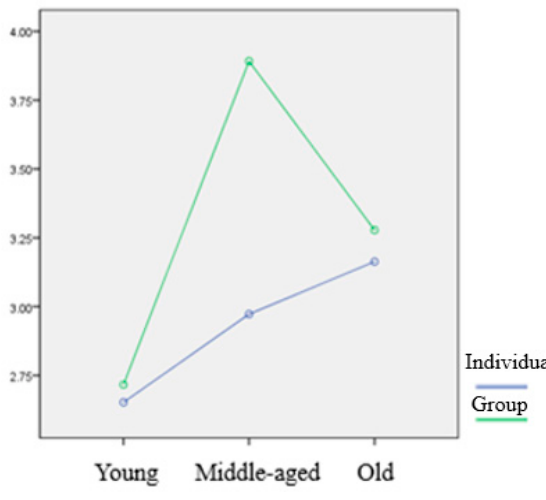
Figure 1. Interaction effects of Disease Phobia.